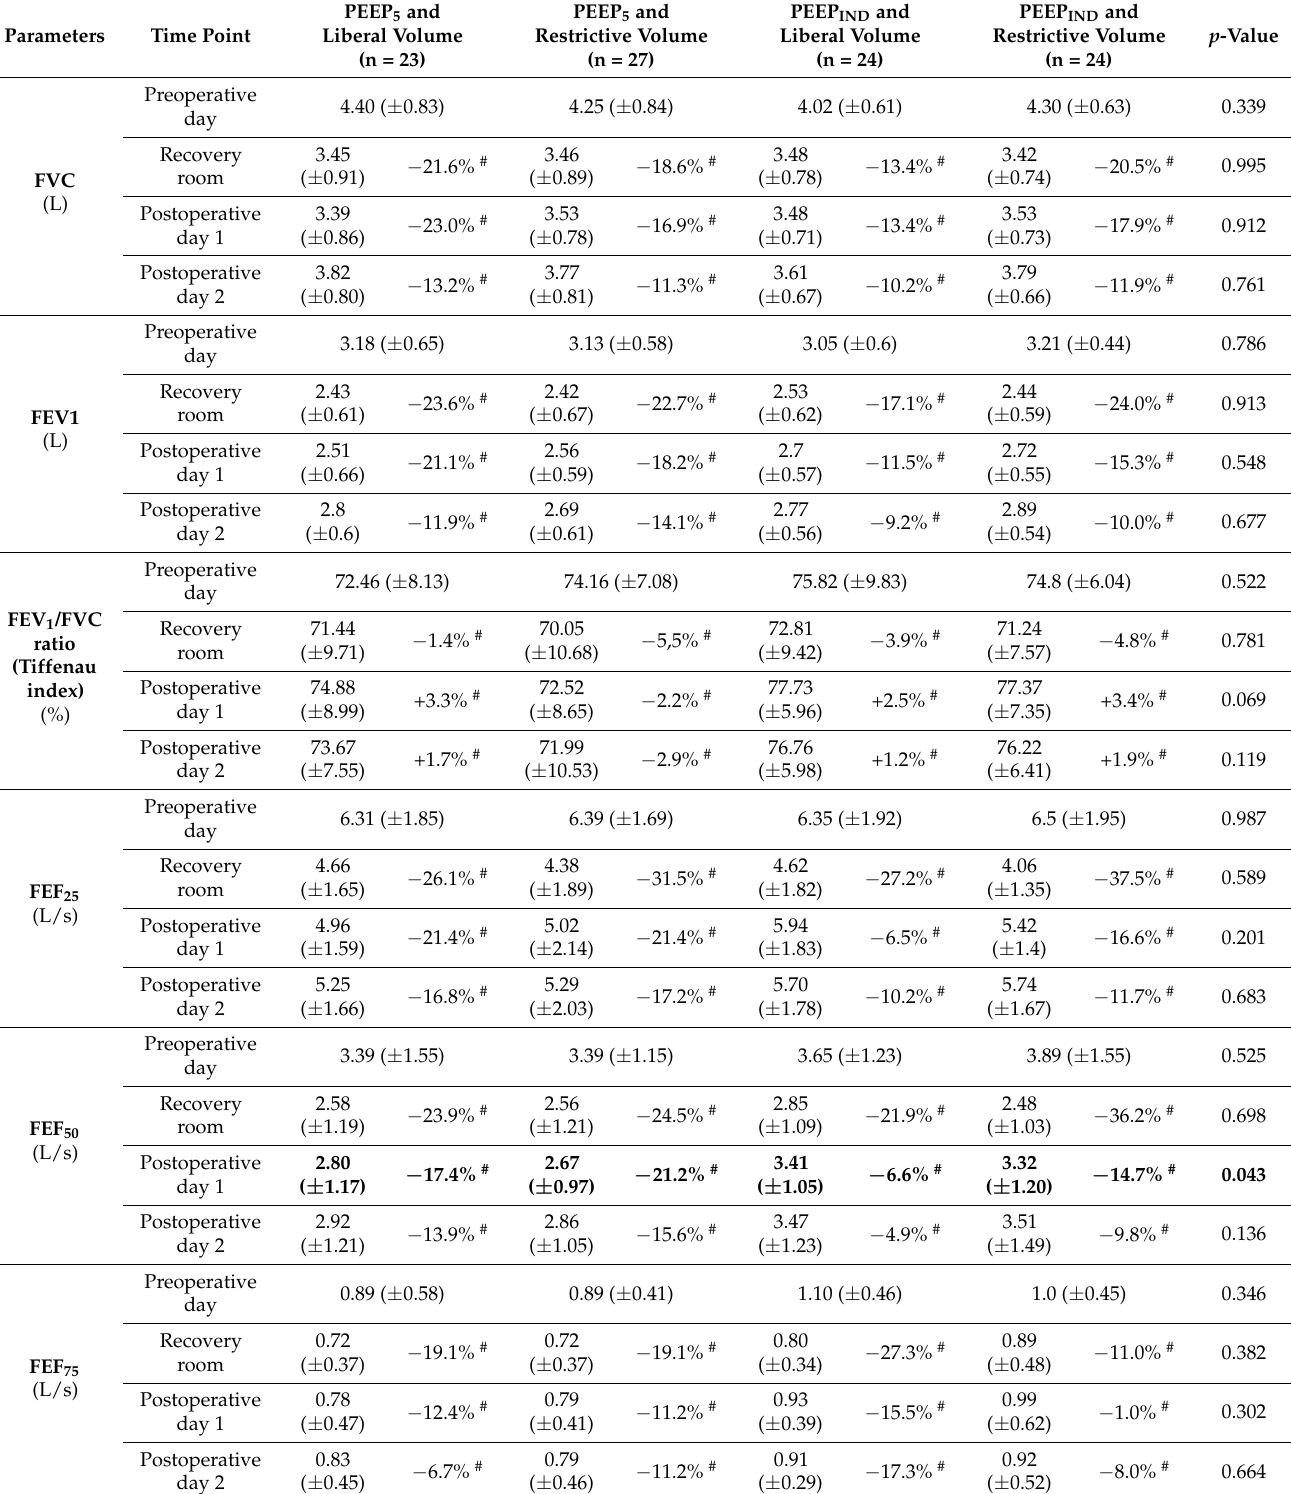
Table 2. Comparison of spirometric parameters between four study groups at four time points: the day before surgery, in the recovery room and on the first and second postoperative day (n =